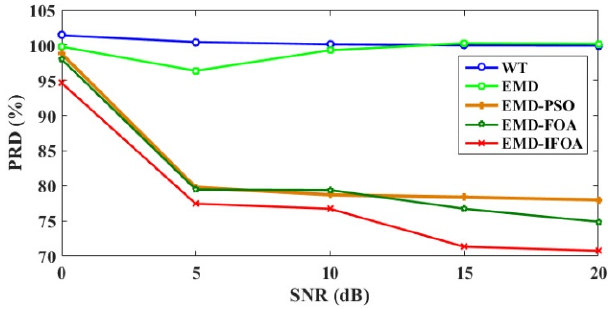
Figure 9. The SNR improvement of the five methods in different SNRs. SNR imr : signal ‐ to ‐ noise ratio improvement.